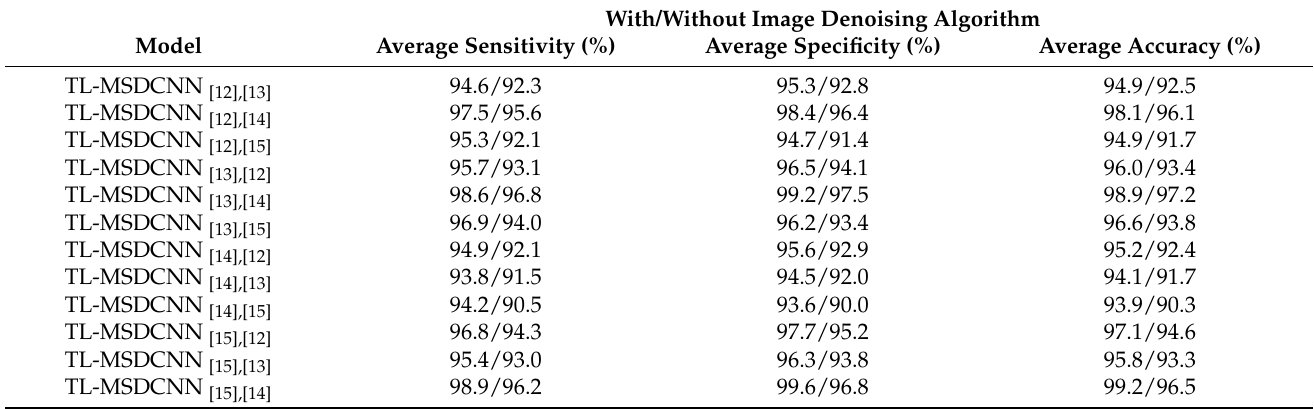
Table 5. Performance of the 12 target models using TL-MSDCNN with and without image denoising algorithm when Gaussian noise is